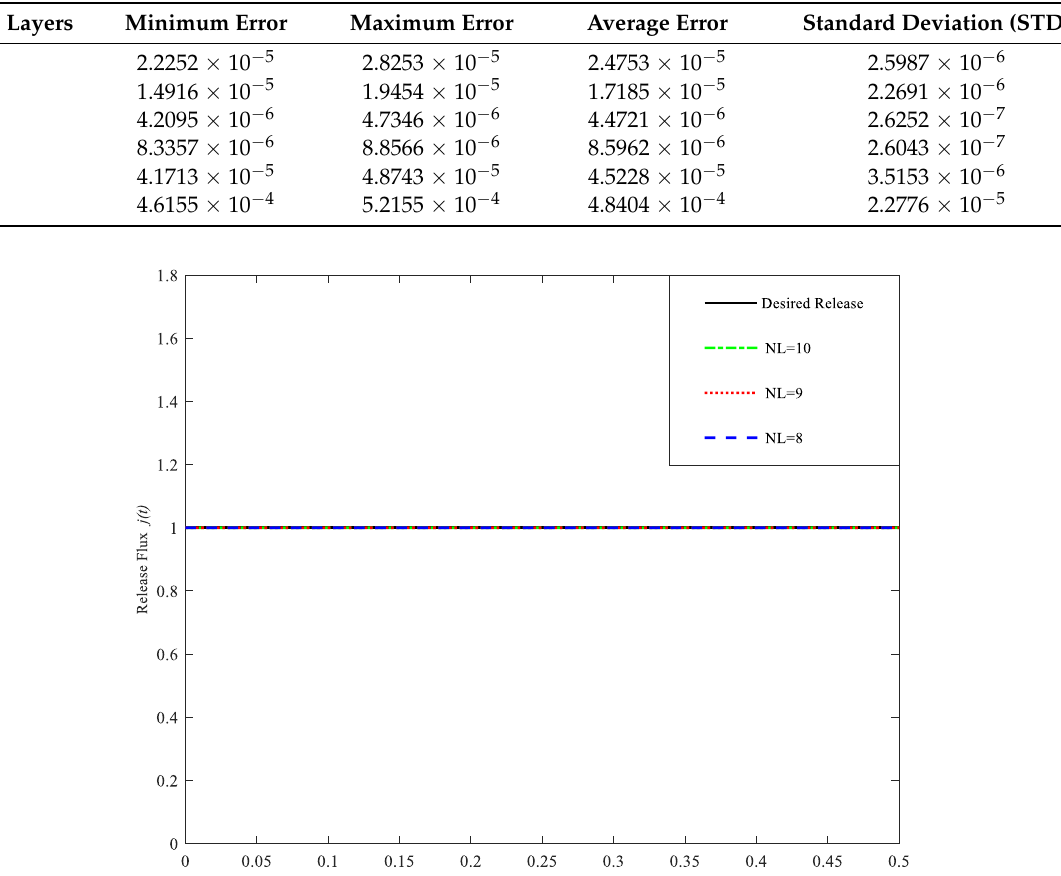
Table 7. Statistical analysis of the error for optimization of the initial drug concentration and diffusion coefficient (Case 1).